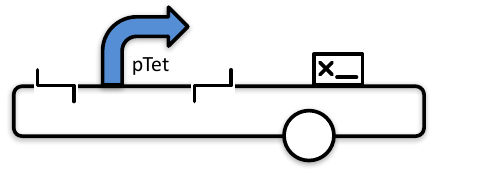
Figure 26: Promoter pTet stored in a circular plasmid. The promoter is prepared for being cut out of the plasmid: it is preceded by a 5’ sticky end restriction site and followed by a 3’ stick end restriction site. In addition, the plasmid has been bar-coded with a signature and has its origin of replication marked.